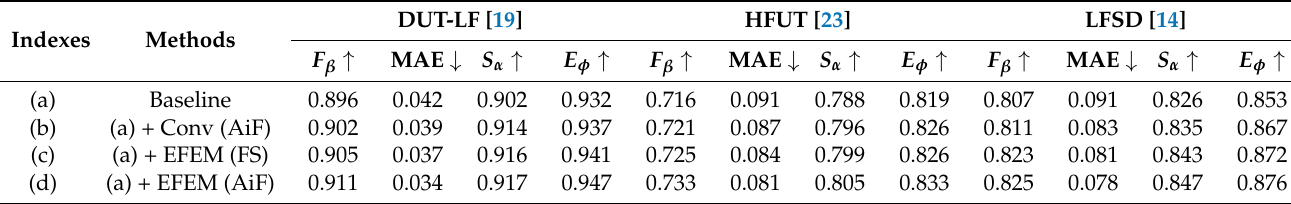
Table 2. Quantitative results of different edge feature extraction methods. (a) denotes the baseline network with no edge features extracted. (b) represents using a convolutional layer to extract edge features from all-in-focus (AiF) images. (c) means using EFEM to extract edge features from